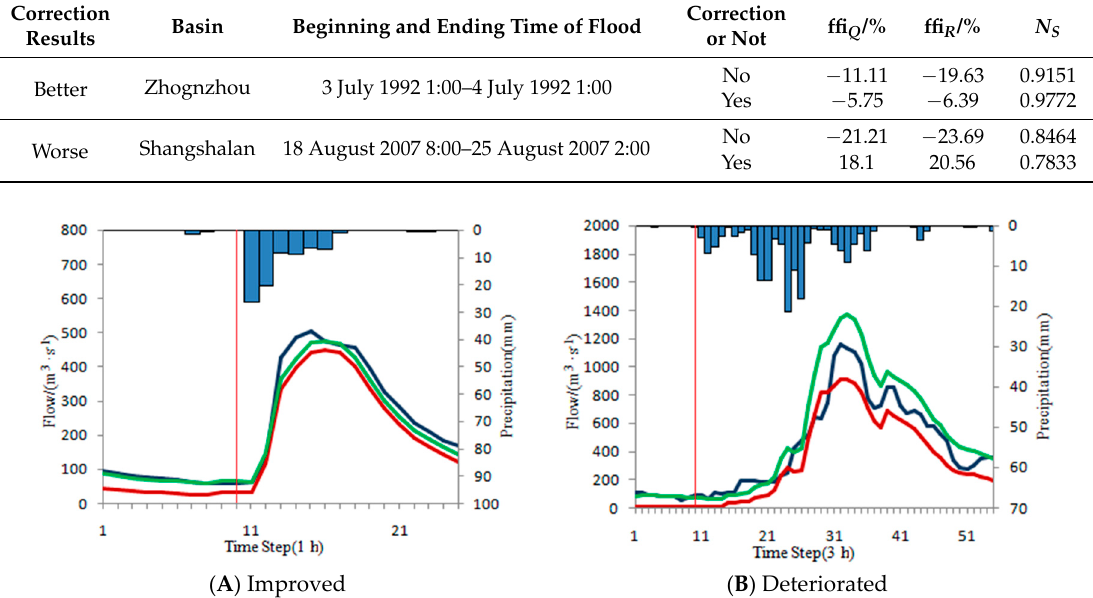
Figure 10. Accuracy improved and deteriorated floods of under-estimated floods.